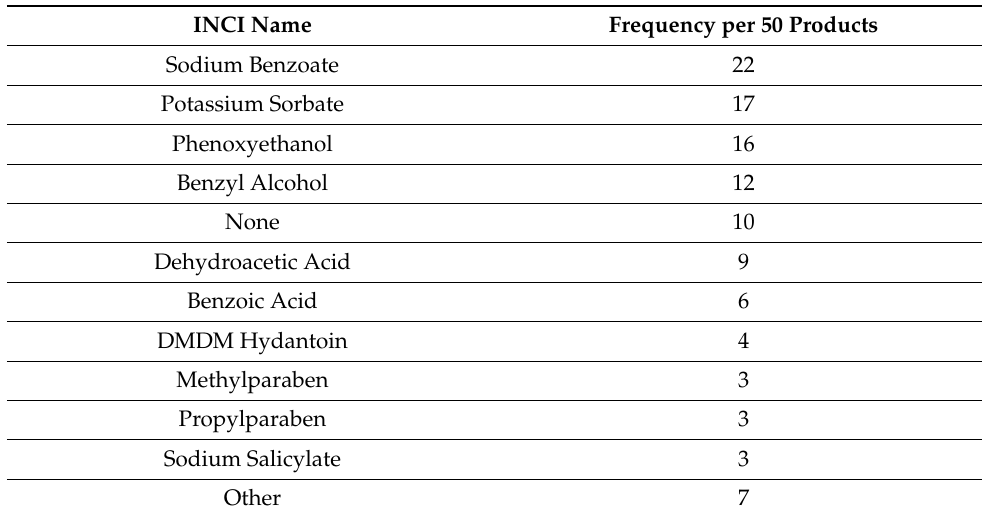
Table 3. Frequency of preservatives in analyzed abrasive cosmetics.